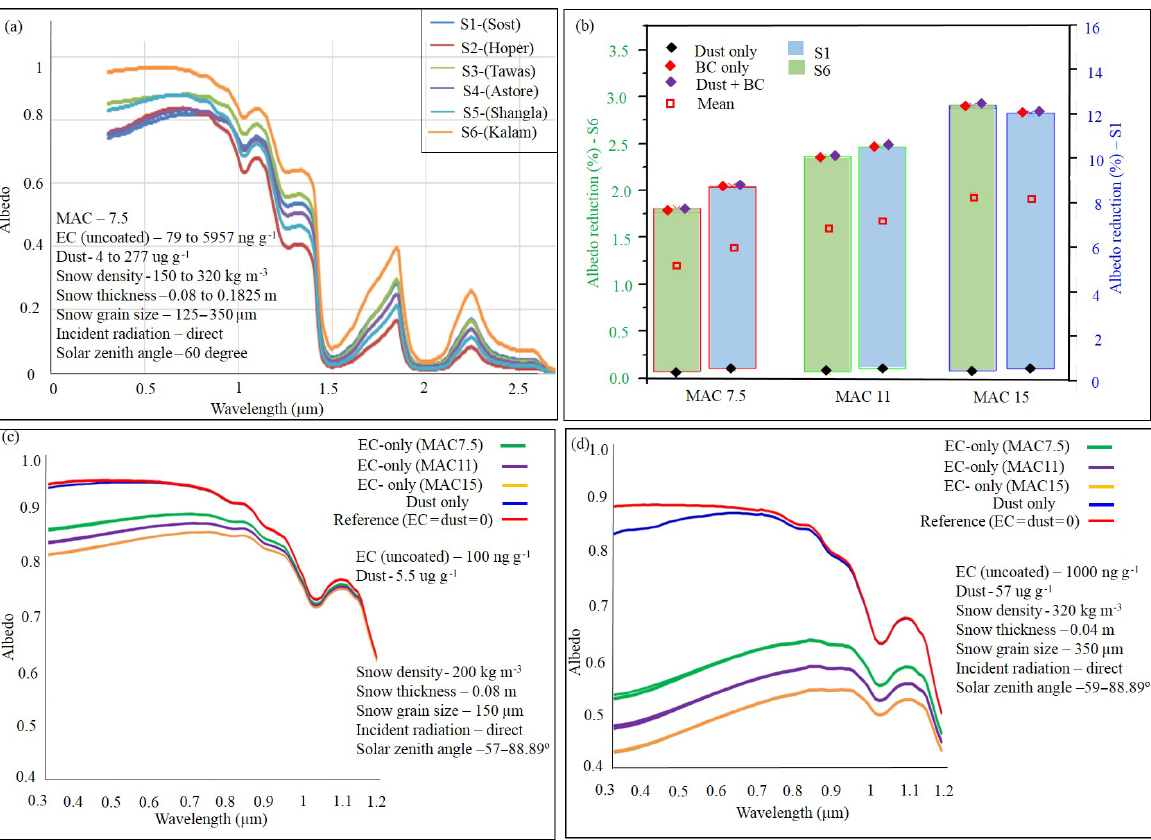
Figure 3. Spectral variation in albedo for winter sampling sites and selected mass absorption cross-section (MAC) values: (a) average albedo of samples at each of the sites; (b) daily mean albedo reduction of fresh snow (site S6) and aged snow (site S1) snow (note different scales of y axis); (c) albedo of fresh snow site S6; (d) albedo of aged snow site S1.